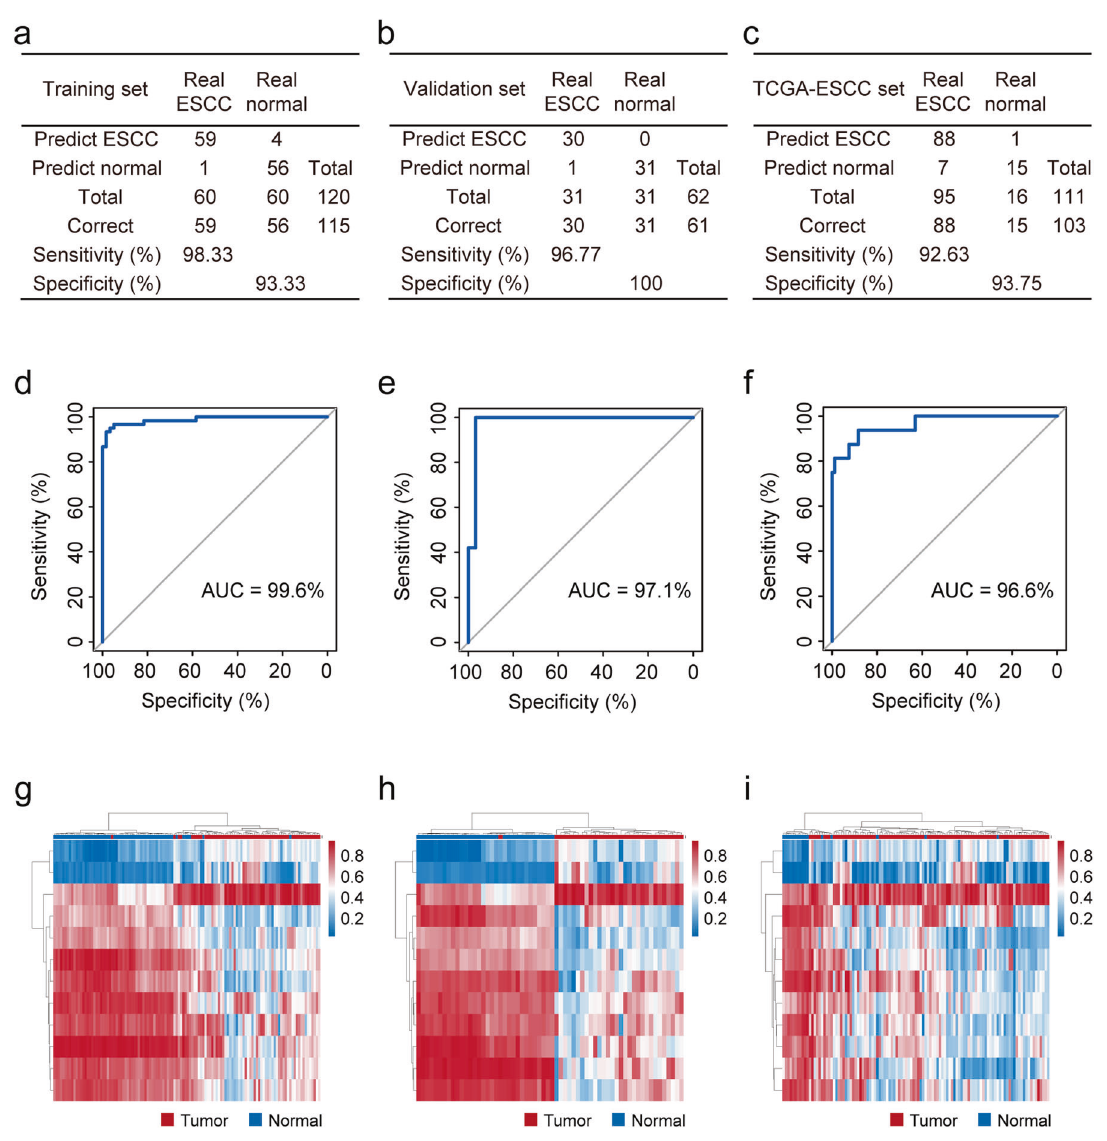
Fig. 4 Diagnosis of ESCC with a DNA methylation panel. a – c The confusion tables of binary results of diagnostic prediction model in the training ( a ), validation ( b ) and TCGA ESCC ( c ) datasets. d – f The receiver operating characteristic curve (ROC) of the diagnostic prediction model in the training ( d ), validation ( e ) and TCGA ESCC ( f ) datasets. g − i Unsupervised hierarchical clustering and heatmap of 12 methylation markers screened for constructing the diagnostic prediction model in the training ( g ), validation ( h ) and TCGA ESCC ( i )